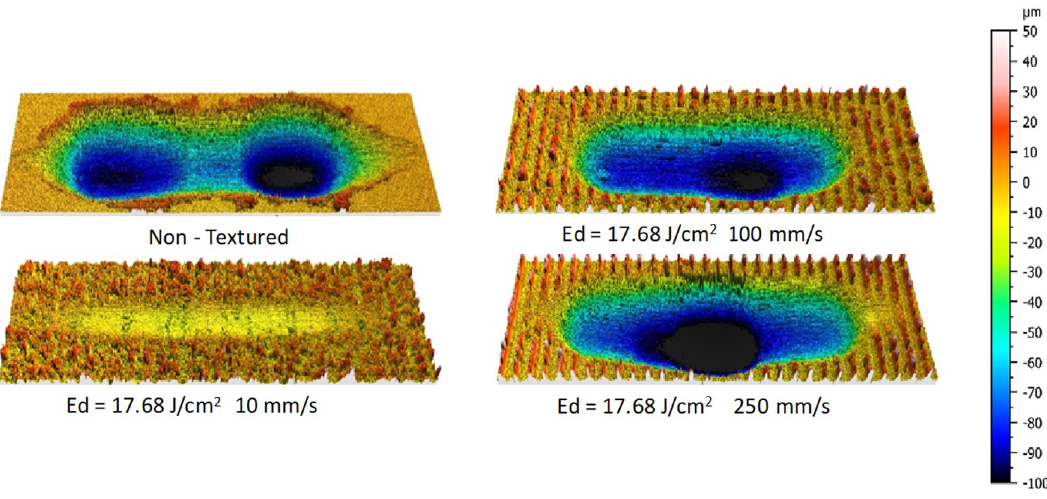
Figure 7. Worn morphologies of sliding track as a function of V s .